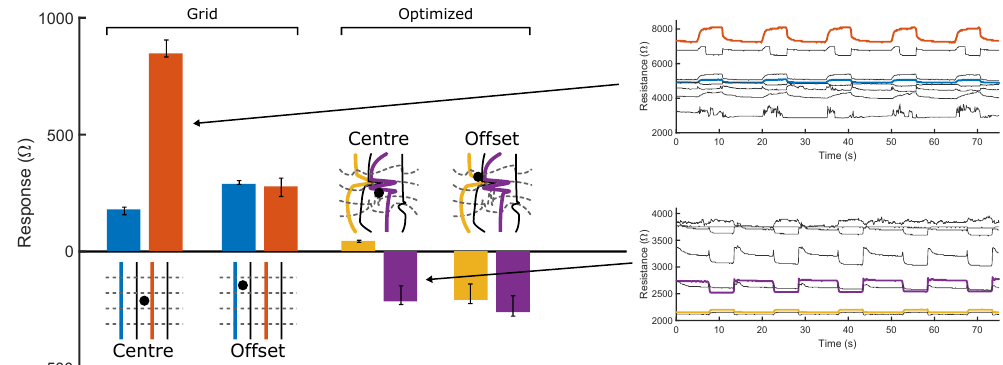
Figure 6. Relative magnitude of the resistive responses at central and offset probe locations. Central and offset positions are probed 10 times for both the grid and the optimized morphologies, with the responses from two of the eight sensor channels (depicted in blue and orange) being plotted. Two characteristic resistive time-series responses to 5 repeated 2 mm-deep probes at the skin’s centre are shown, one from each